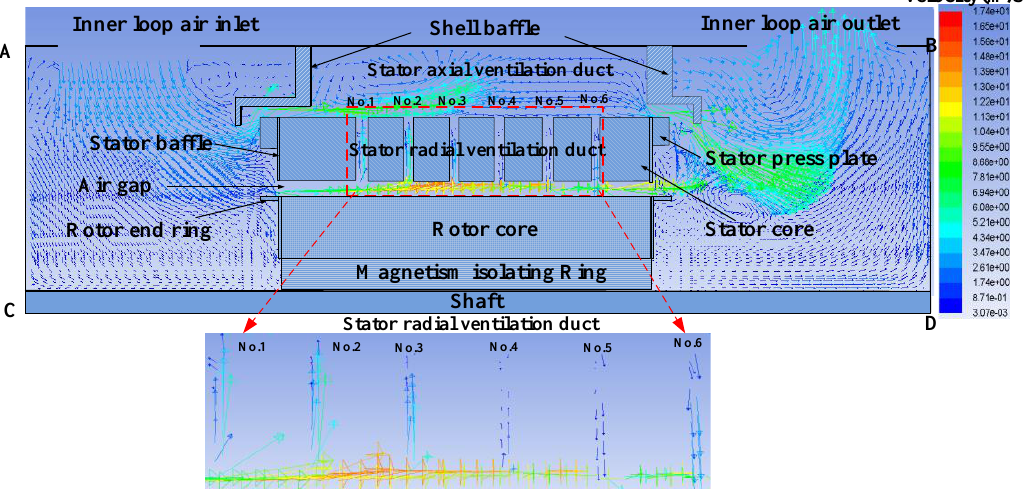
Figure 11. Cross-section A-B-C-D of fluid distribution in the motor with dual ventilation path air-cooled system.